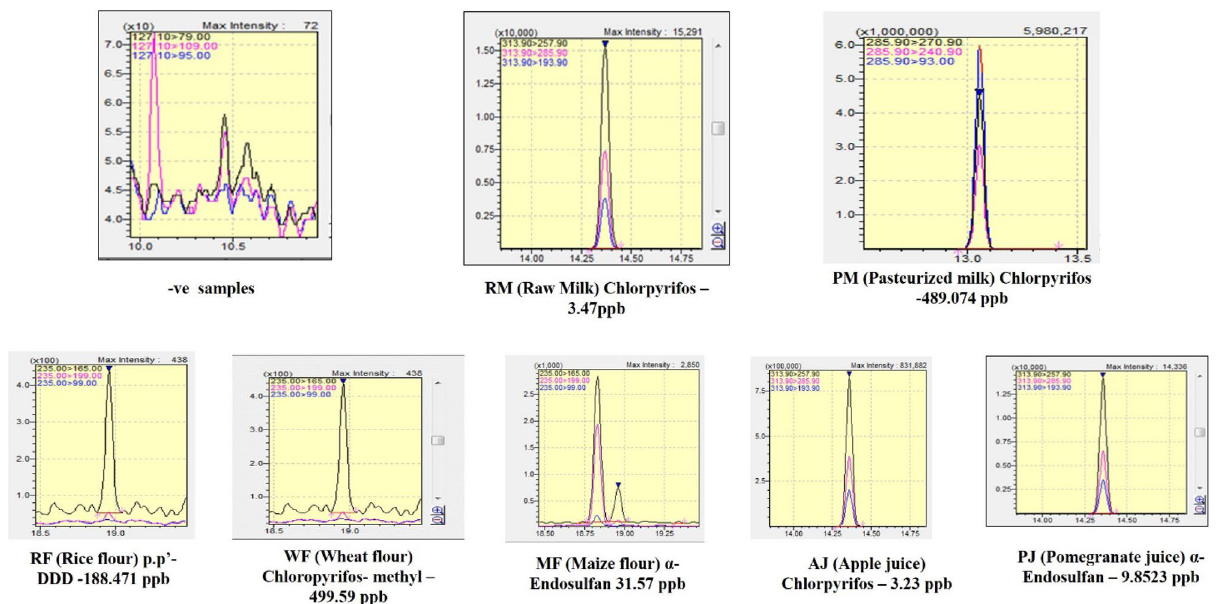
Figure 3. Confirmation of pesticides residues in milk, cereal based foods, and fruit juices quantitatively by GC–